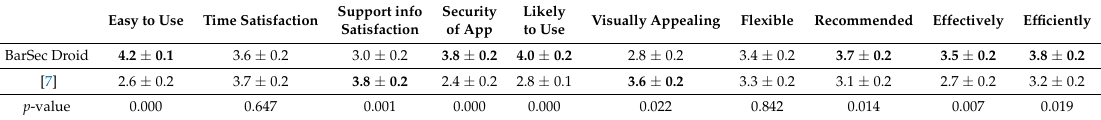
Table 7. T -test Results for BarSec Droid vs. QR Droid